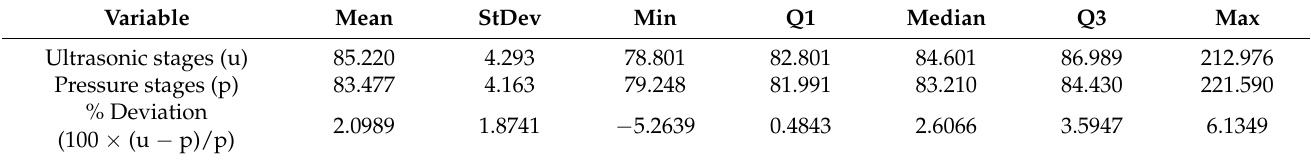
Figure 3. Correlation between water stages (in cm) measured with the pressure transducer and the ultrasonic sensor at Pikrodafni stream. Table 1. Main statistics calculated for the ultrasonic and pressure water stage data values ( N =